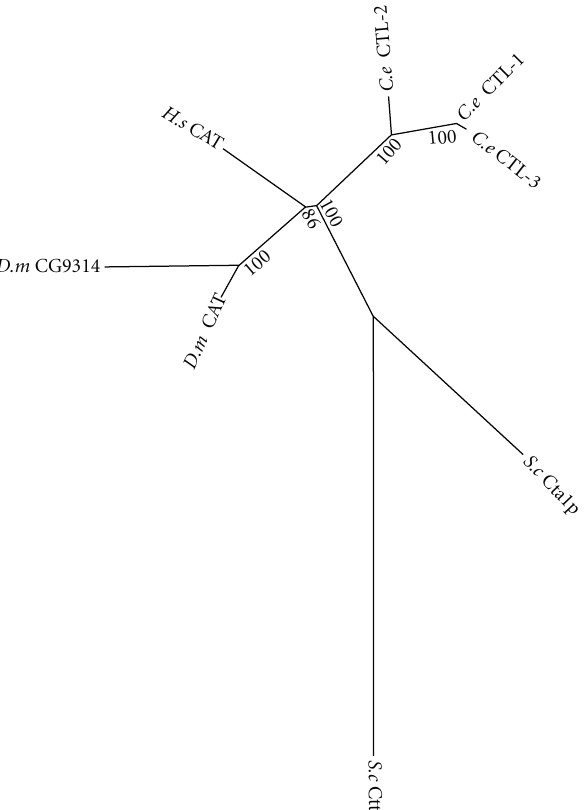
Figure 13: Maximum likelihood majority-rule bootstrap consensus tree of catalase proteins. See Figure 6 for details on the phylogenetic